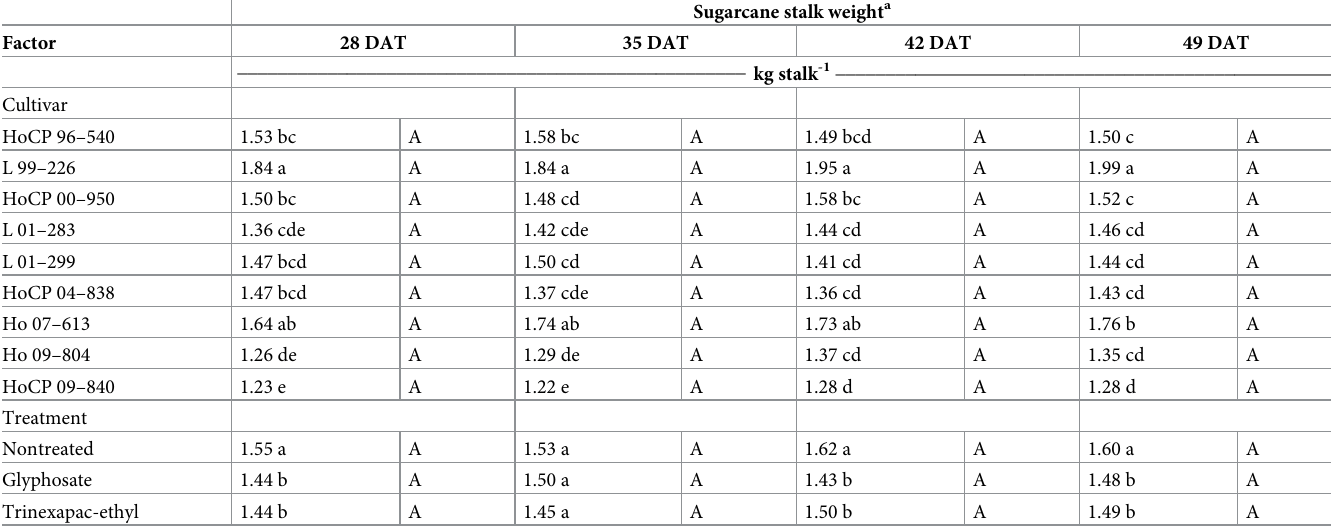
Sugarcane stalk weight a